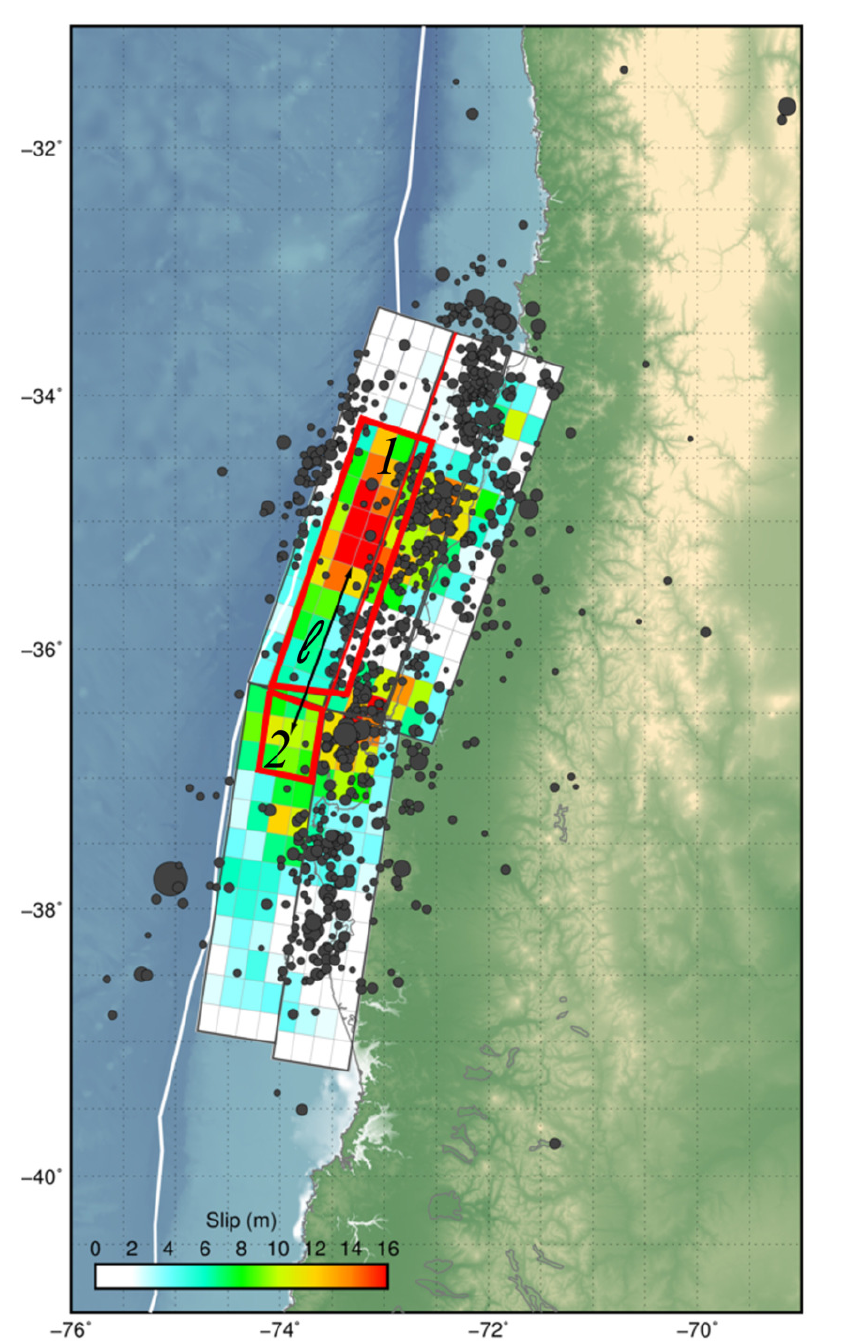
Figure 2. Map of the fault that originated the 2010 Maule earthquake, with the slip distribution retrieved by [30]. Asperities 1 and 2 are